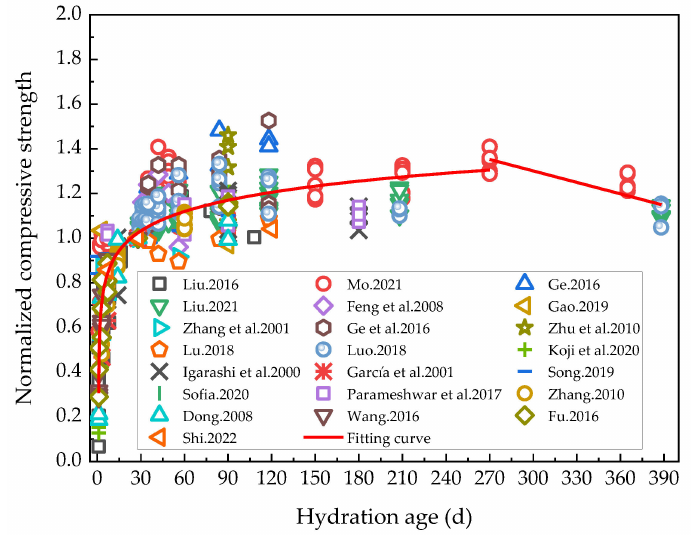
Figure 3. Variation curve of the normalized compressive strength with rehydration age